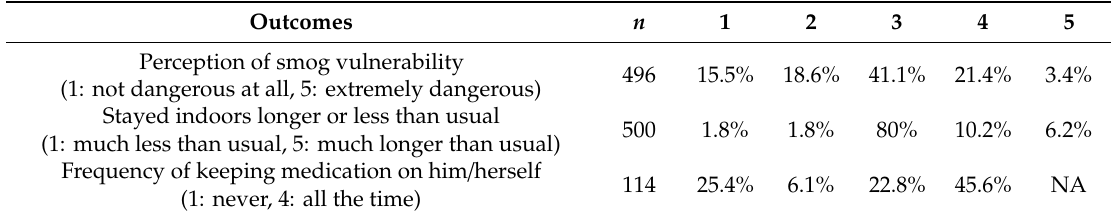
Table 5. Ex post measurement of outcomes measured on ordinal